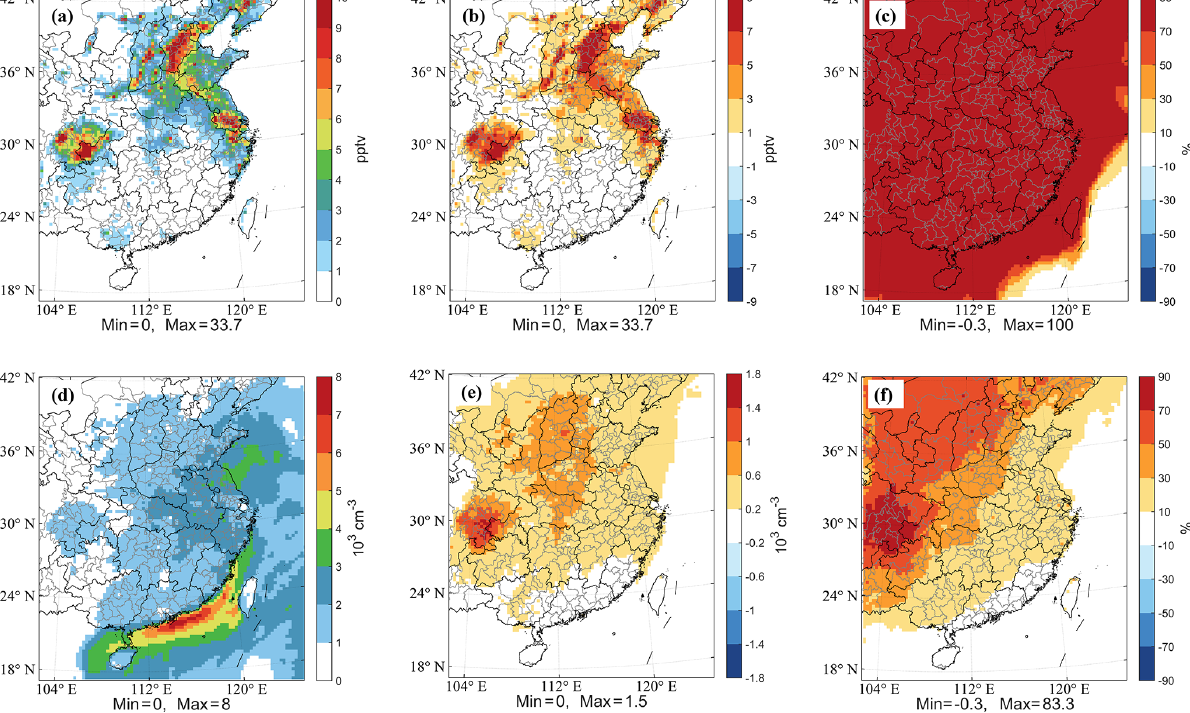
Figure 6. Spatial distributions of modeled Cl 2 (a) and Cl radical (d) average concentrations in November 2011 in the Base experiment; the differences (Base minus NoCl) of modeled Cl 2 (b) and Cl radical (e) average concentrations in November 2011; the percent changes of the NoCl experiment to the Base experiment of modeled Cl 2 (c) and Cl radical (f) average concentrations in November